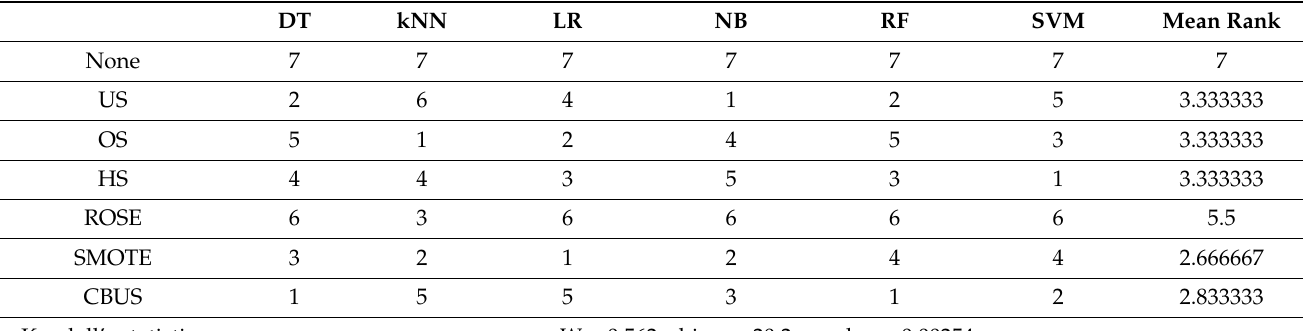
Table 14. Ranks of DBT for different